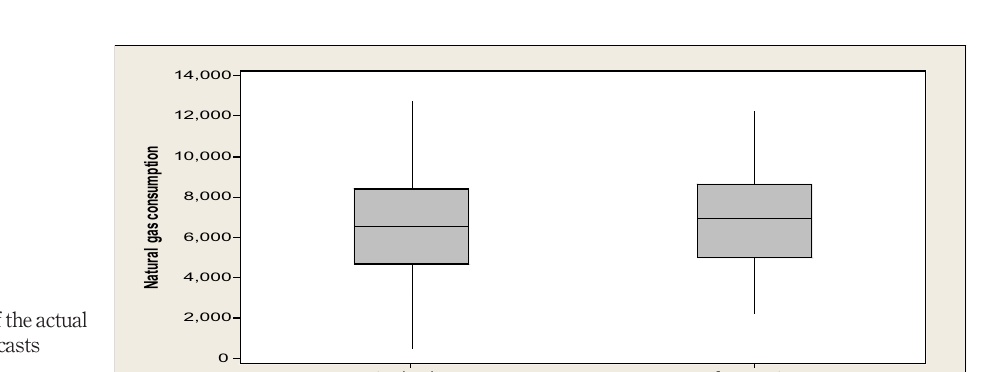
Figure 7. Time plot of the actual vs the forecasts values up to one week